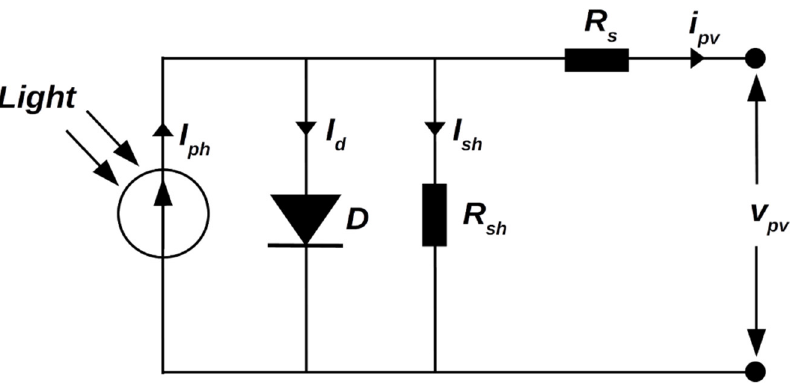
Figure 11. Solar panel performance; ( a ) the measured indoor I-V characteristic curve and ( b ) the measured outdoor I-V characteristic curve.